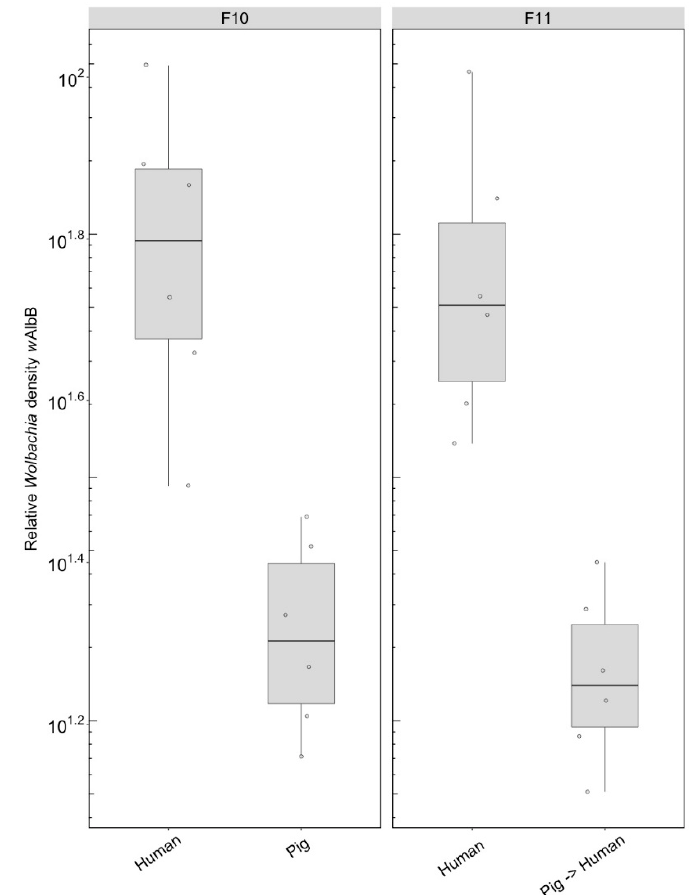
Figure 8. Comparison of the relative Wolbachia density of the w AlbB infections across the different blood sources (human, pig) after 10 generations of maintenance. Each dot represents the density of an individual mosquito. The boxplots represent the first to the third quartiles around the median (horizontal grey line) and the vertical bars represent the 1.5 interquartile of the lower and upper quartiles. Around six individuals per blood source were tested.